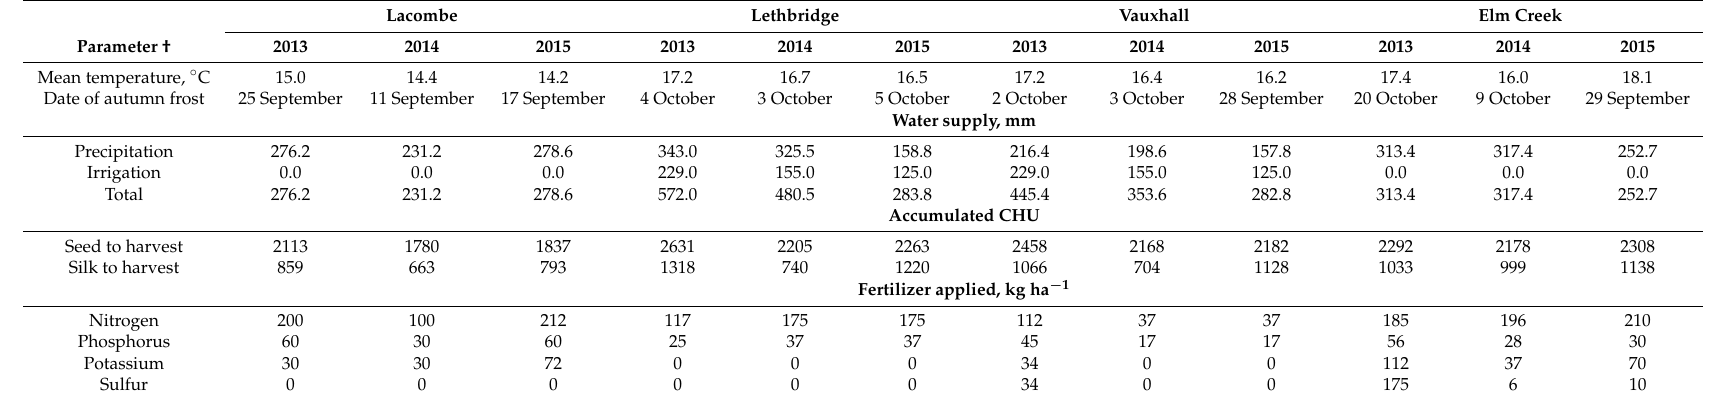
Table 4. Environmental data, accumulated corn heat unit (CHU), and inorganic fertilization rate at Lacombe, Lethbridge, and Vauxhall (Alberta) and Elm Creek (Manitoba) over three